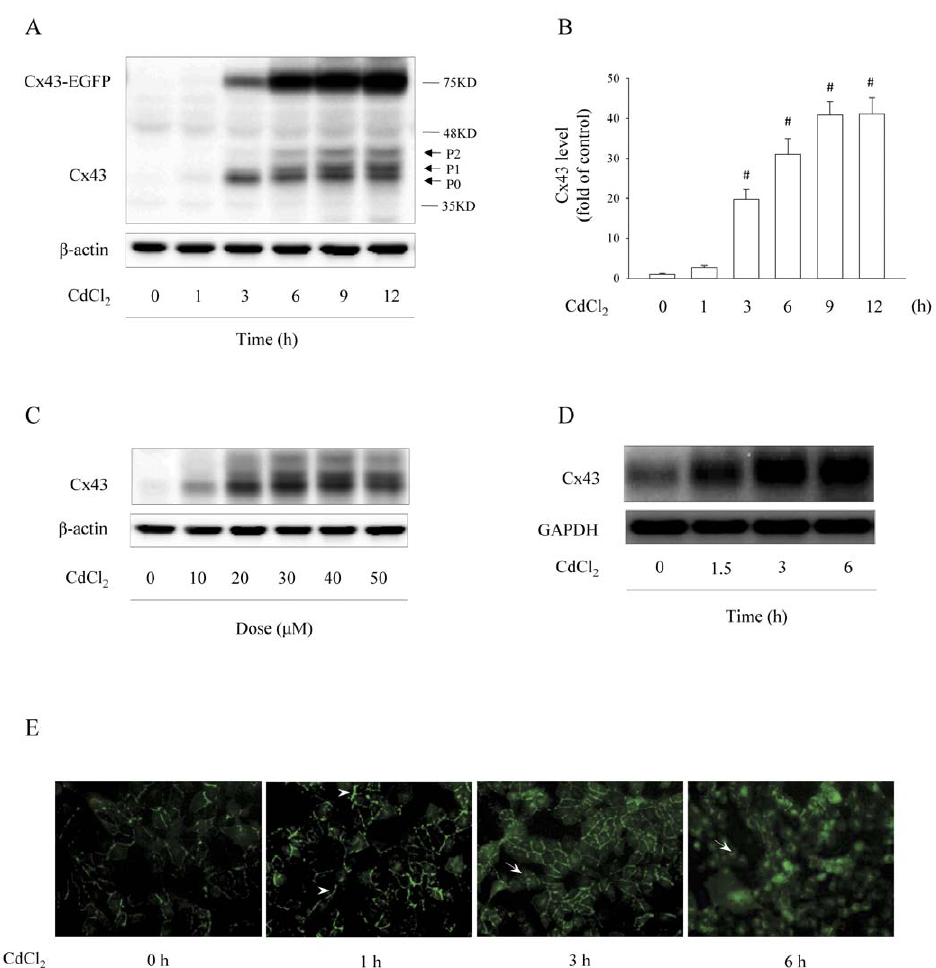
Figure 1. Effects of Cd 2 + on Cx43 expression in Cx43-LLC-PK1 cells. (A–C) Time- and dose-dependent effects of Cd 2 + on Cx43 protein levels. Cx43-LLC-PK1 cells were treated with 35 m M CdCl 2 for the indicated duration (A) or exposed to the indicated concentrations of CdCl 2 for 6 h (C). The cellular protein was extracted and subjected to Western blot analysis of Cx43. In Western blot (A), Cx43 was detected at the molecular near 70 kDa (upper band) and 43 kDa, representing EGFP-tagged and untagged Cx43, respectively. P0, P1 and P2 denoted the nonphophorylated, phosphorylated and hyper-phosphorylated Cx43. (B) Densitometric analysis of Cx43 expression shown in A. Results were expressed as induction relative to the basal level of Cx43 (mean 6 S.D., n=3). # p , 0.01 versus untreated control. (D) Effect of Cd 2 + on Cx43 mRNA expression. Cx43-LLC-PK1 cells were exposed to 35 m M CdCl 2 for the indicated duration. Cellular RNA was extracted and subjected to Northen blot analysis of Cx43. The level of GAPDH was shown as a loading control. (E) Effect of Cd 2 + on Cx43-EGFP distribution. LLC-PK1 cells permanently transfected with a vector encoding Cx43-EGFP were exposed to 35 m M CdCl 2 . The expression and localization of Cx43-EGFP at different time points following Cd 2 + stimulation were shown. Note the obviously increased expression of Cx43-EGFP and shift of fusion protein from cell membrane (arrow head) to perinuclear region (white arrow) after incubation with Cd 2 + .